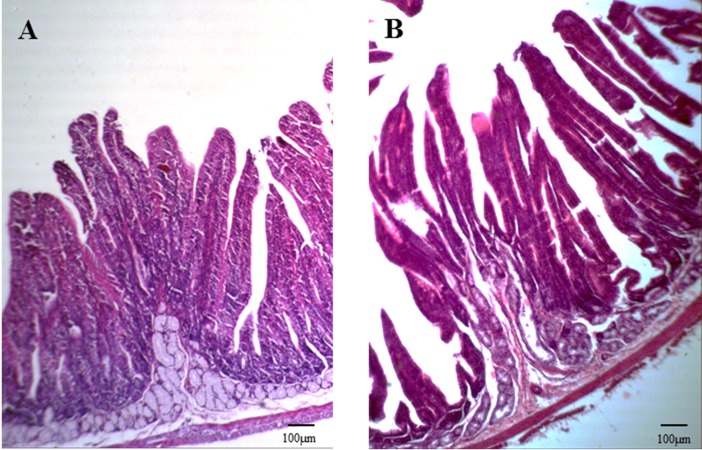
Duodenal section from a healthy rabbit and rabbit with diarrhea (HE staining, 100×).The intestinal wall, villi, and crypt of the duodenum of three weaned rabbits with diarrhea and three healthy weaned rabbits were measured.